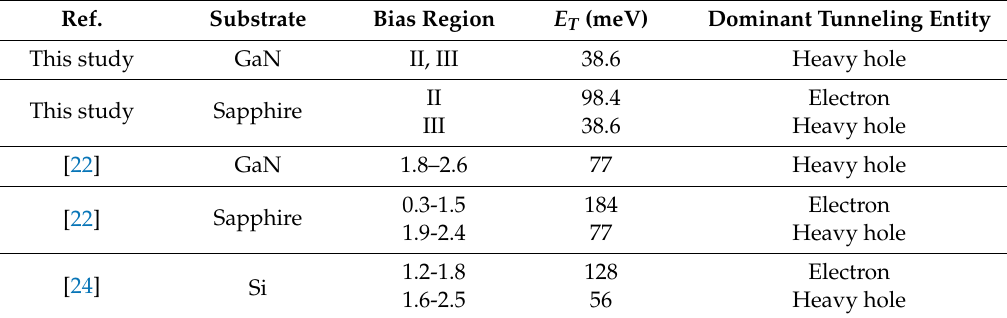
Table 1. Summary of tunneling analysis of LED I and LED II. The obtained values are deduced from Equation (3).